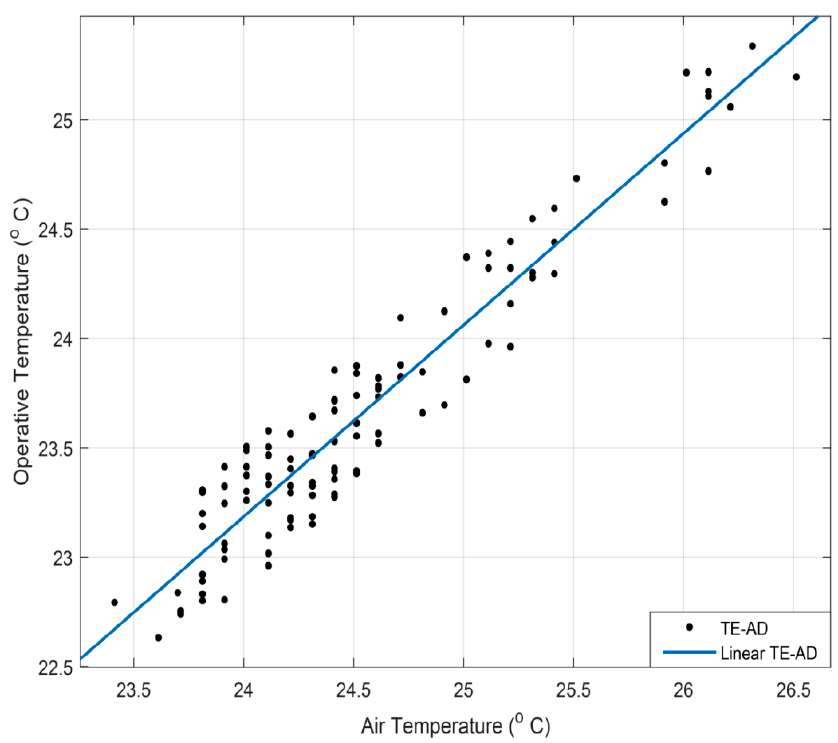
Figure 17. Linear regression between operative and air temperature.